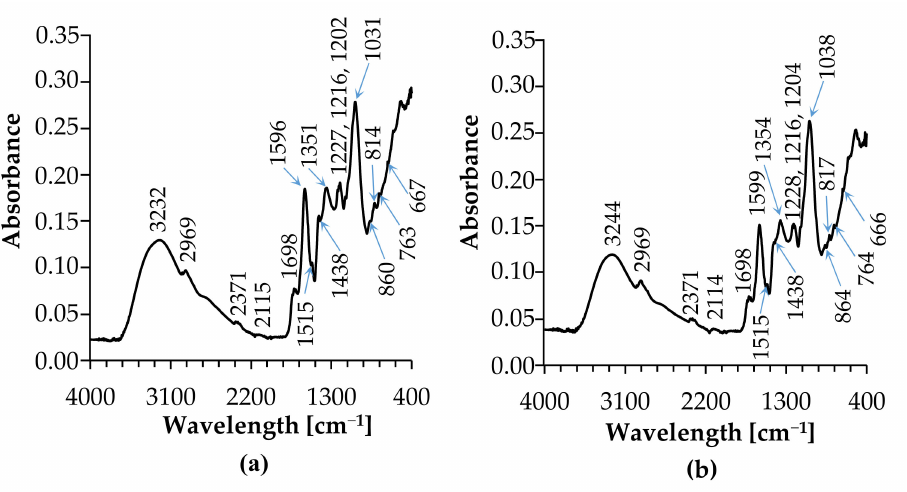
Figure 6. FTIR spectra of C. incanus leaves extract ( a ), and infusion ( b ). FTIR peaks are assigned for stretching and bending vibrations that indicate particular functional groups. The FTIR absorption bands of the C. incanus leaves extract and infusion are assigned and summarized in Table